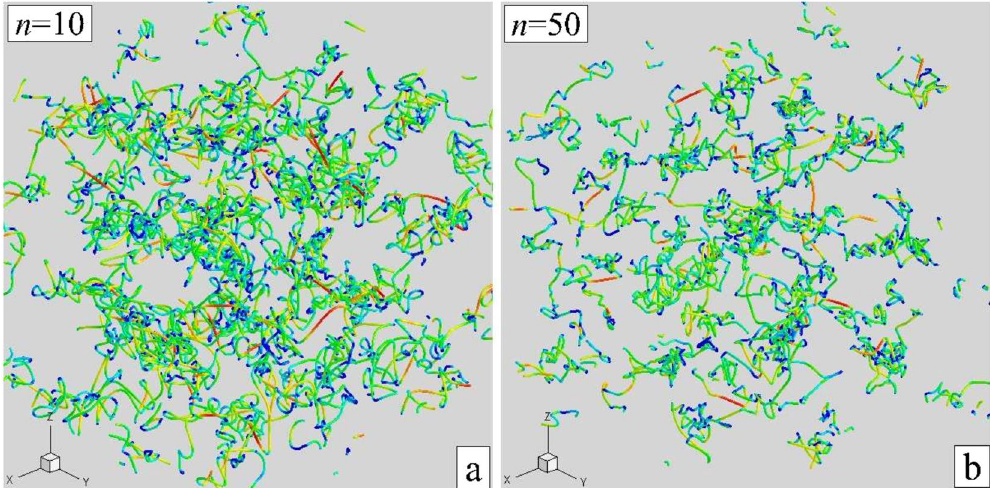
Figure 5. Particle trajectories within a cubic box with the side length  a 5 , chosen near the center of the simulation cell, demonstrating the particle motion in IPL melts for n = 10 ( a ) and n = 50 ( b ). The trajectories are color-coded according to particle energy (transition from red to blue corresponds to the decrease in energy). The time interval during which the trajectories are followed corresponds roughly to one hundred of inverse Einstein